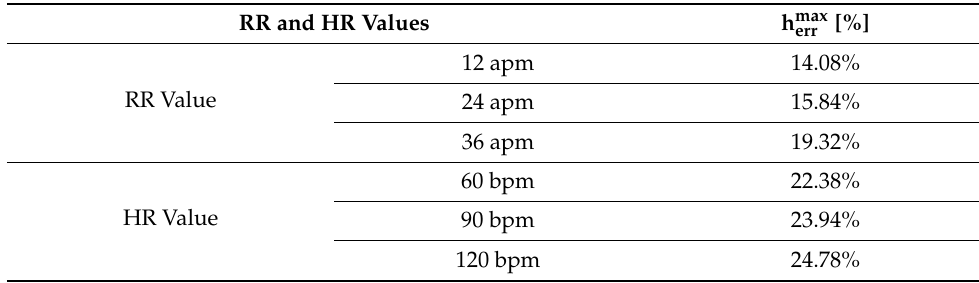
Table 2. Values of h max err expressed in percentage. RR and HR